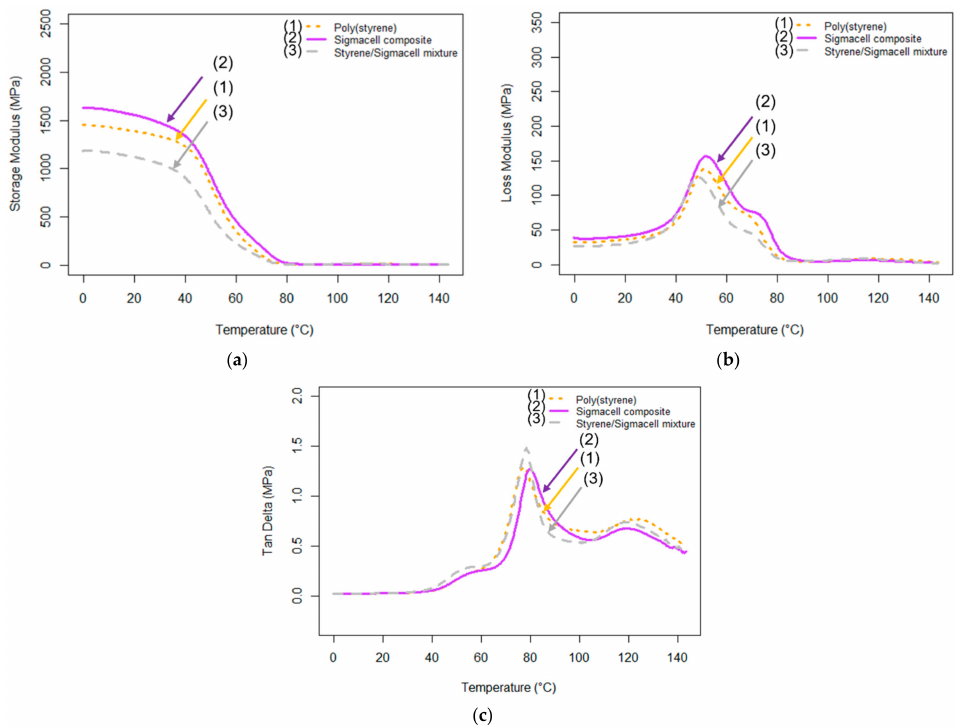
Figure 12. DMA thermograms of tested samples: ( a ) Storage modulus E (cid:48) , ( b ) Loss modulus E (cid:48)(cid:48) ,